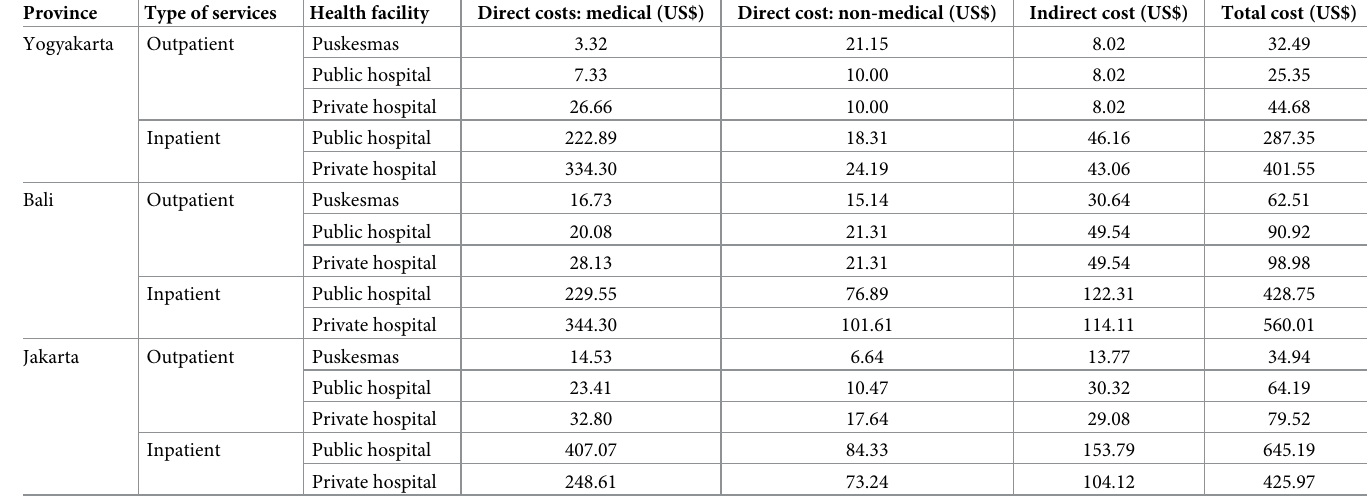
Table 2. Cost of illness per patient per episode (in US$) by component and site in Yogyakarta, Bali and